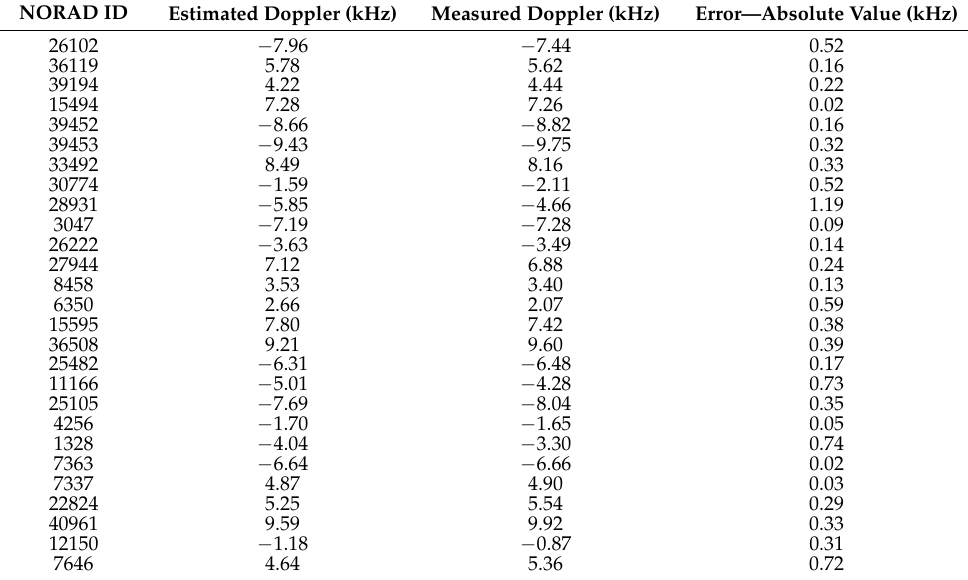
Table 2. Estimated and measured Doppler shift for the 27 objects